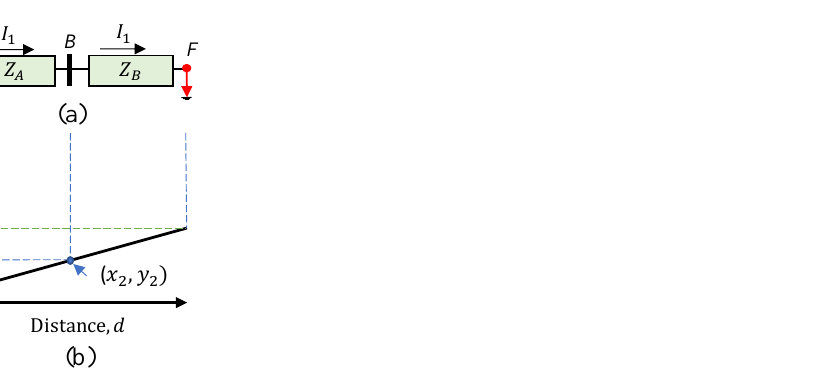
Figure 7. Impedance of radial distribution feeder: ( a ) schematic of a radial distribution feeder; ( b ) impedance seen by DR at A .